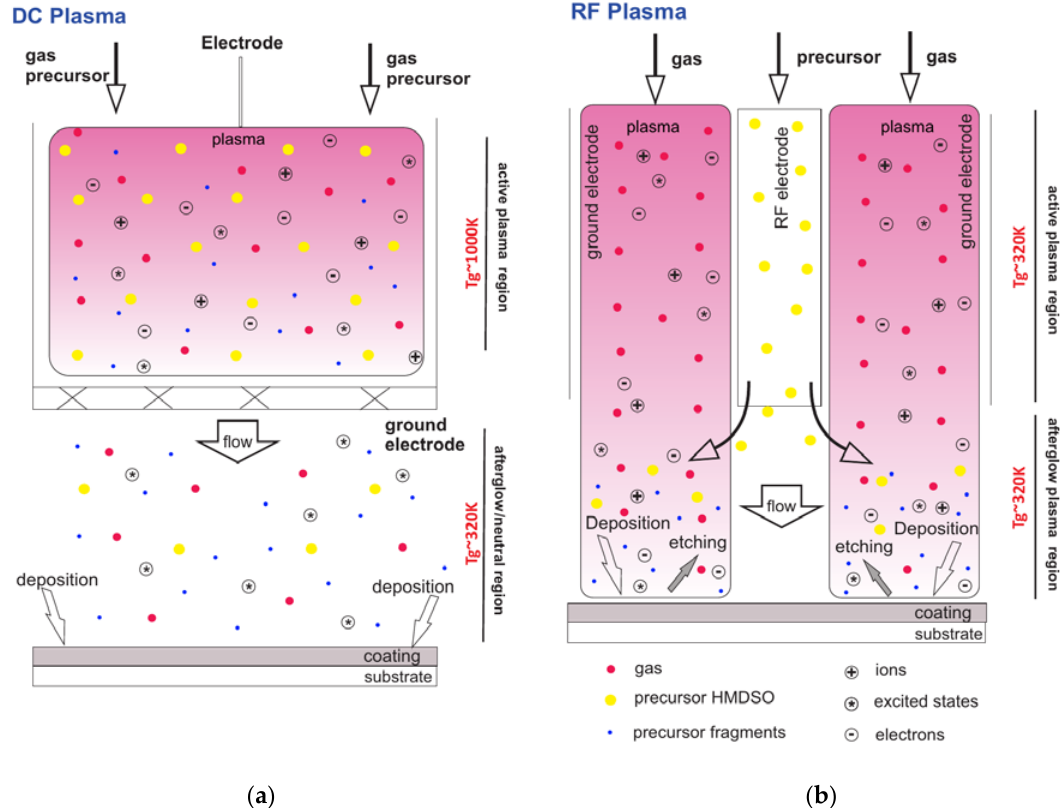
Figure 8. Schematic representation of the deposition process in DC ( a ) and RF ( b ) plasma jets.